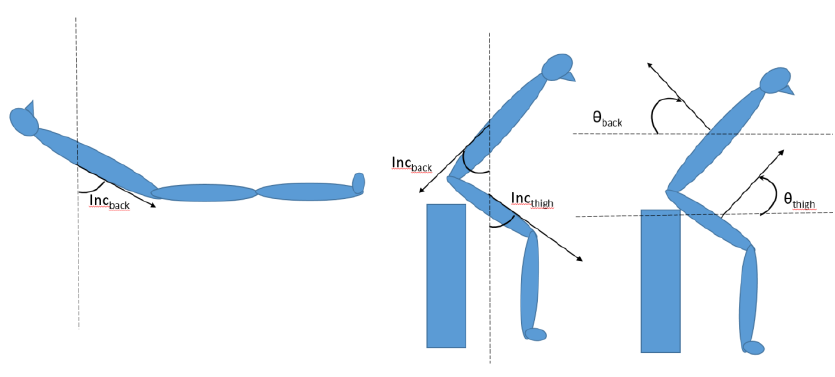
Figure 1. Definitions of the angles used in the equations.